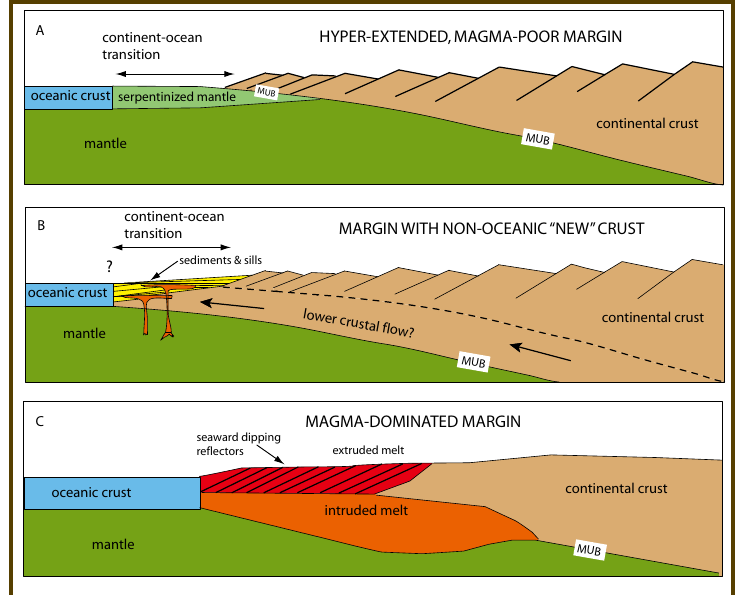
Figure 2. Schematic cross sections of [A] hyper-extended (e.g., Iberia-Newfoundland), [B] non-oceanic ‘new’ crust (e.g., northern Gulf of California), and [C] magma-dominated (e.g., NW Europe-E Greenland, NW Australia) divergent continental margins.